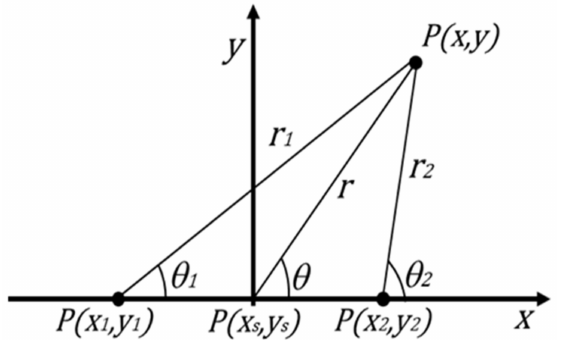
Figure 6. Coordinate system for Sneddon analytical solution modified to account for transformation and rotation of a hydraulic fracture parallel to the X